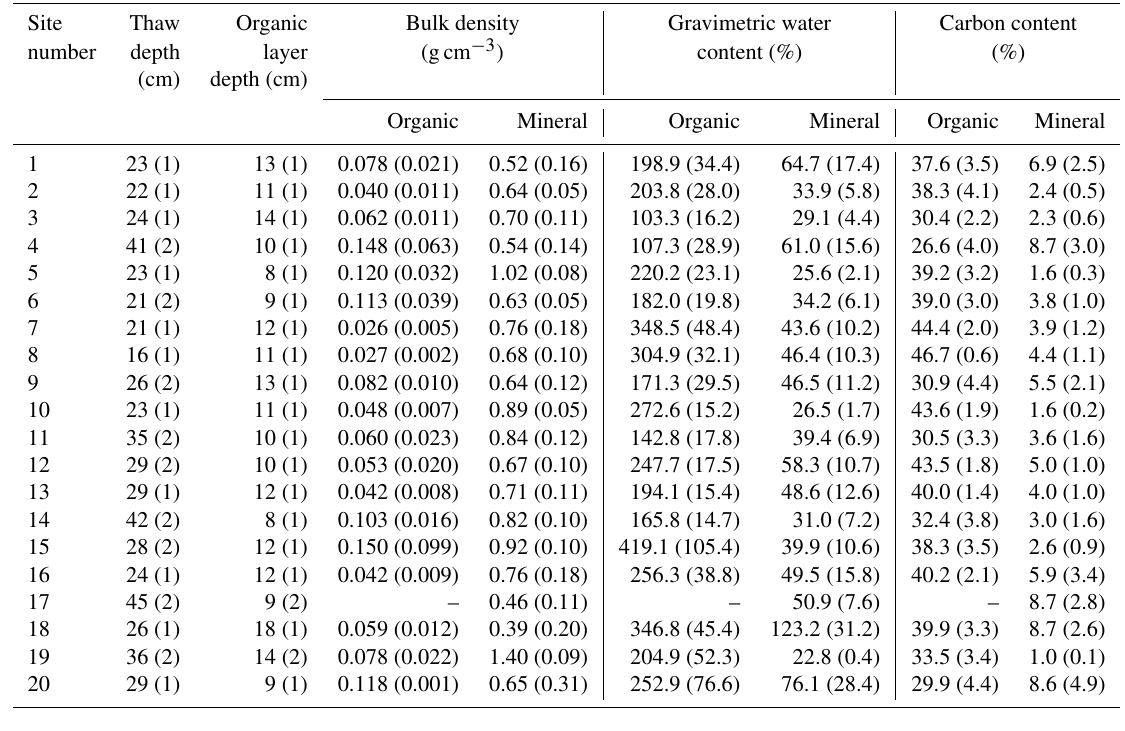
Table 5. Properties of thawed soil in the Y4 watershed. The mineral layer was collected to approximately 10cm below the organic layer (see Methods section). No relationship existed between sample date and thaw depth or sample date and water content. Values in parentheses are standard error.